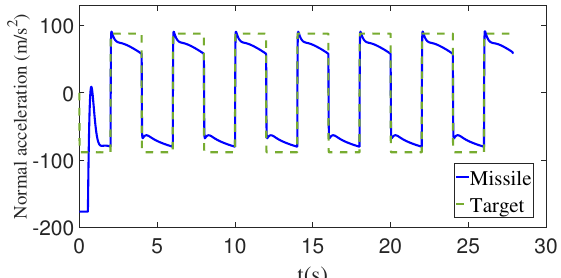
and its estimation ˆ a T α